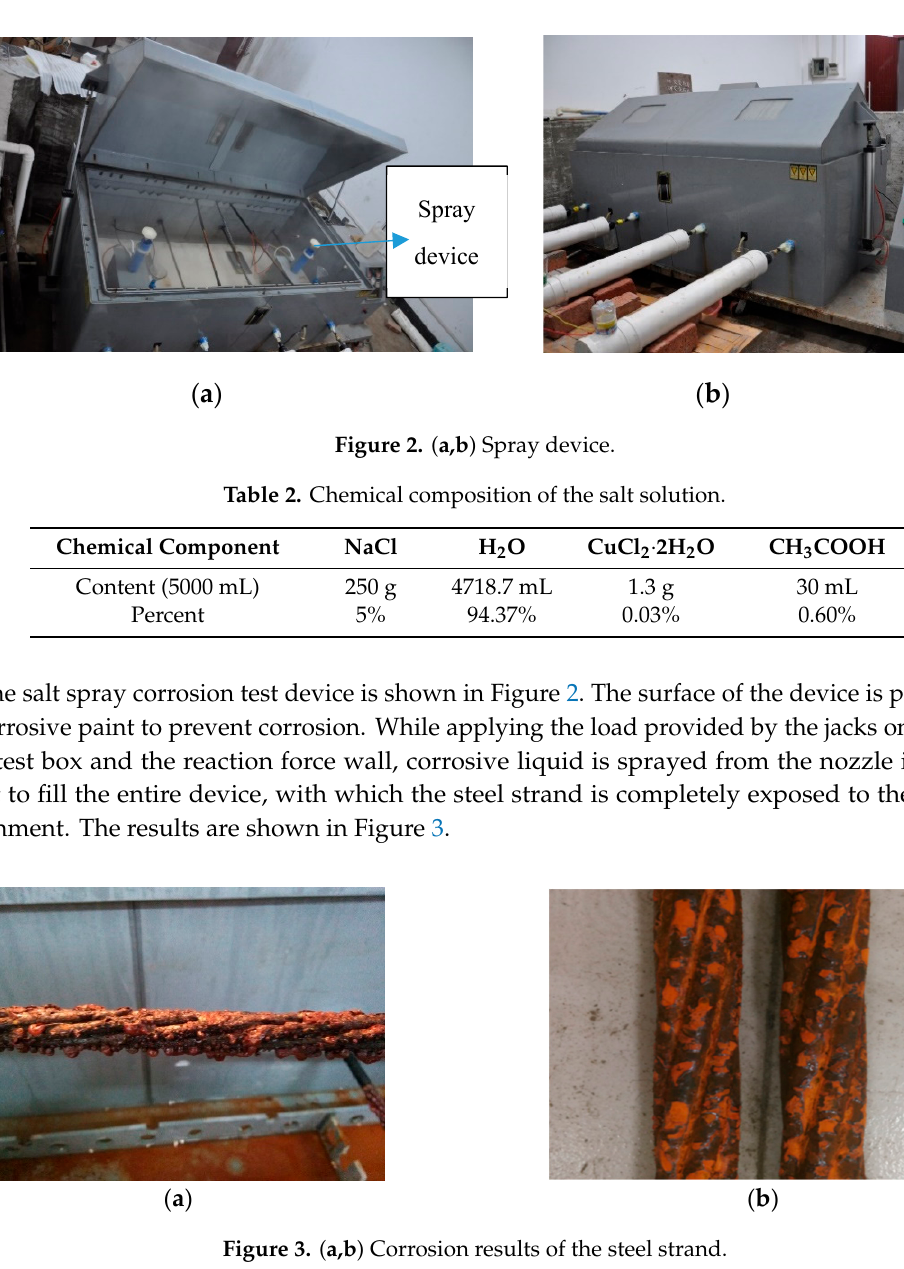
Table 2. Chemical composition of the salt solution.